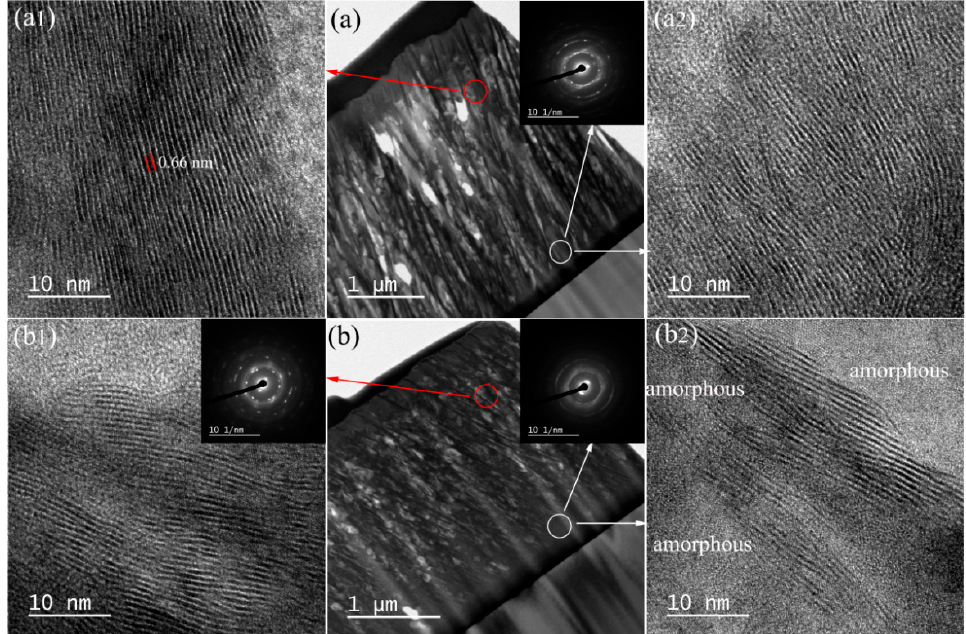
Figure 4. The cross-sectional high-resolution transmission electron microscope (HRTEM) images of WS 2 film: ( a , a1 , a2 ) an overview of FIB-prepared slice of the WS 2 -RT and the magnified image of the selected regions; ( b , b1 , b2 ) an overview of FIB-prepared slice of the WS 2 -40 and the magnified image of the selected regions. The insets are the selected area electron diffraction (SAED) pattern of the marked area.